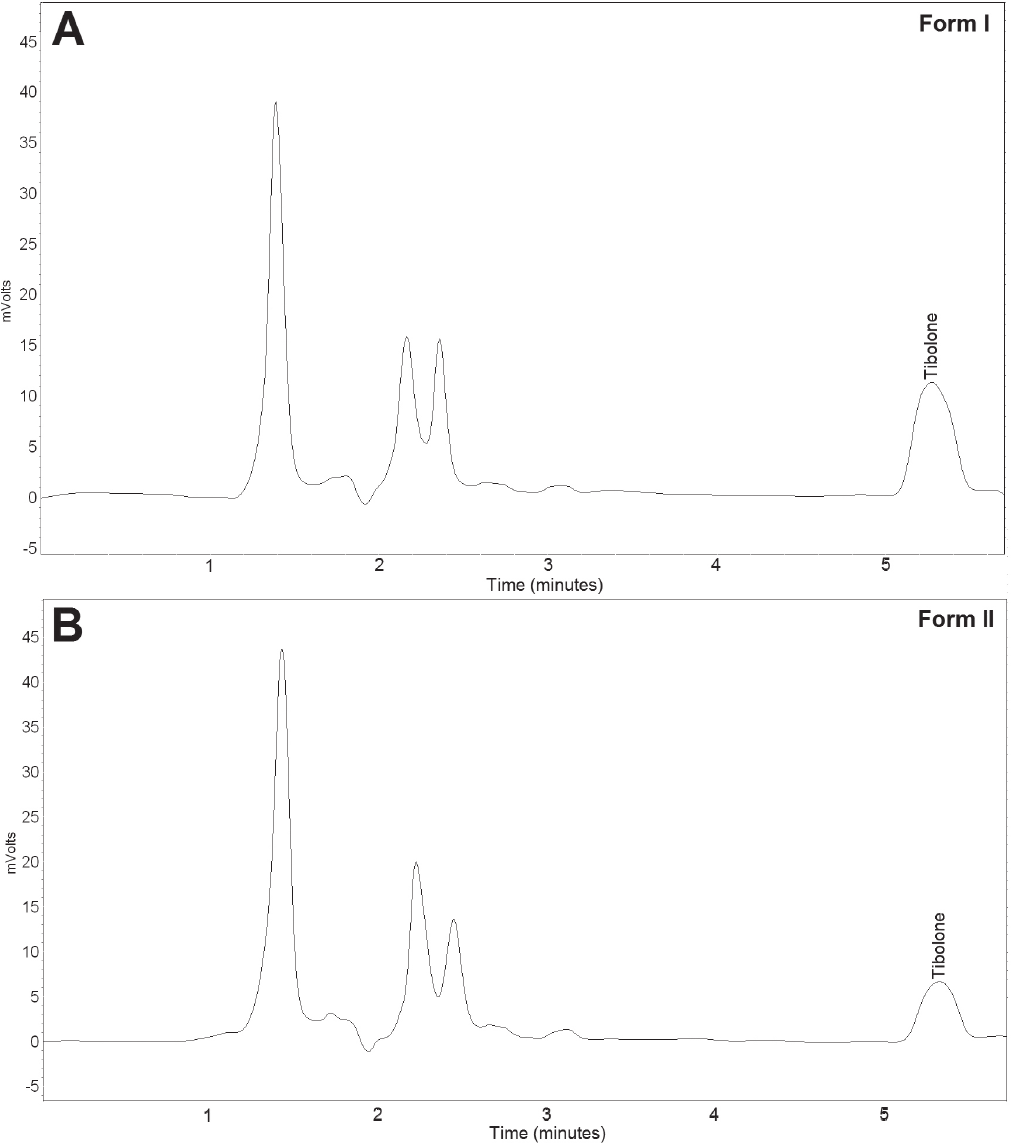
FIGURE 8 - Chromatograms of samples obtained after the 60 minute dissolution test from tablets containing form I (A) and tablets containing form II (B) of